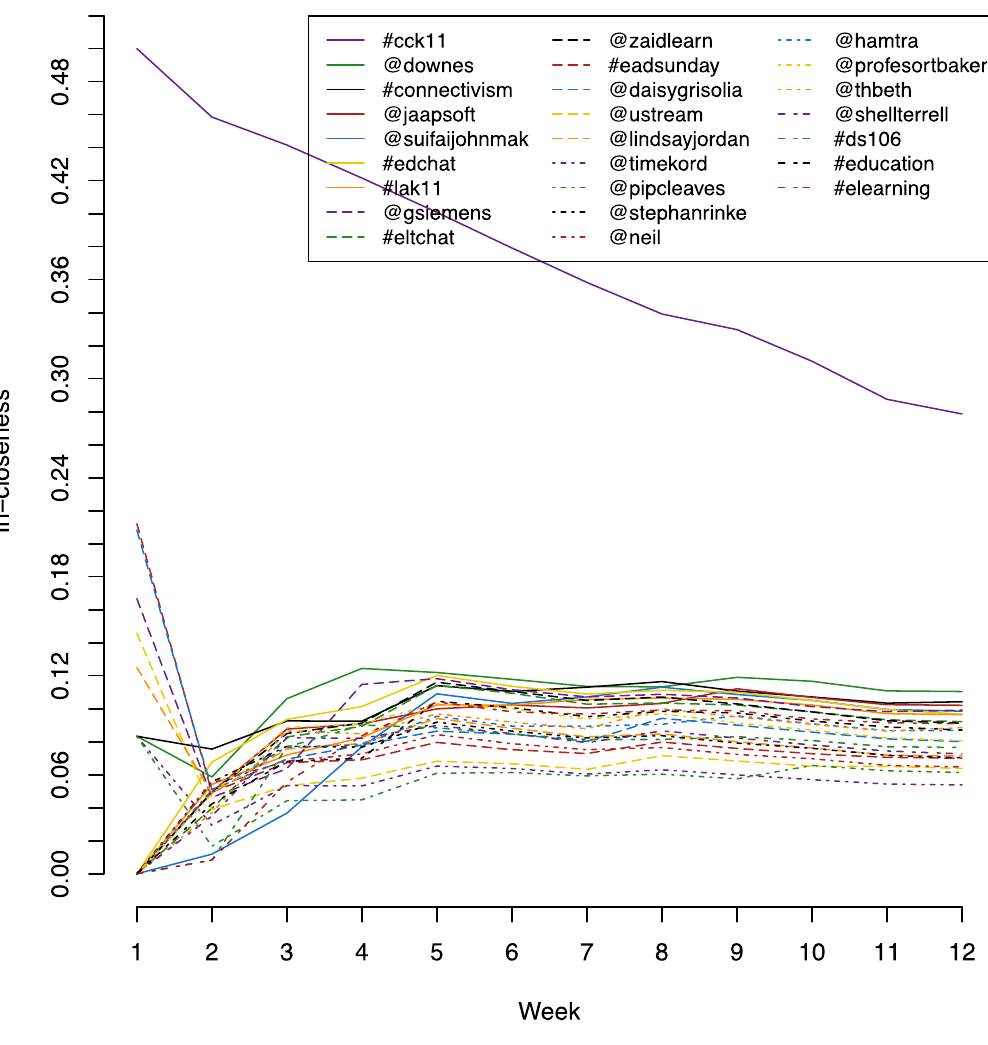
Figure 6. Variation of the input closeness centrality values for the top ranked nodes, over the twelve weeks of the